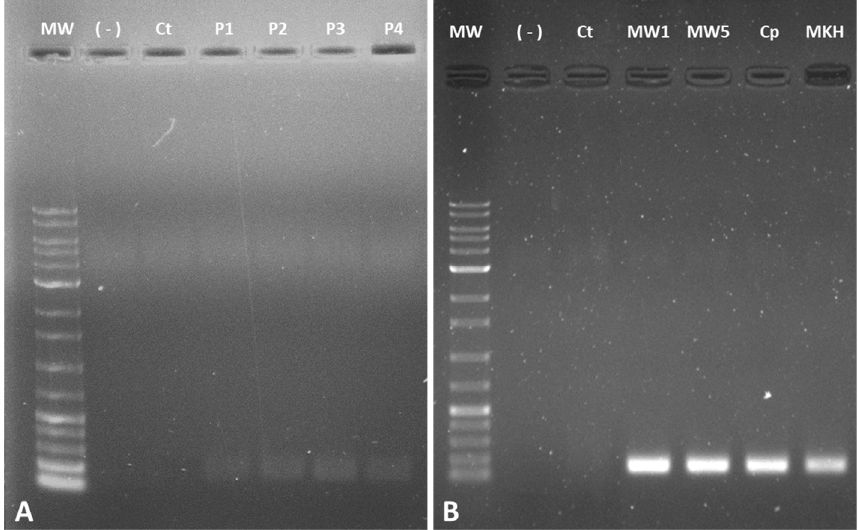
Figure 12. Analysis of GFP gene expression by RT-PCR after transfection of HeLa cells with ( A